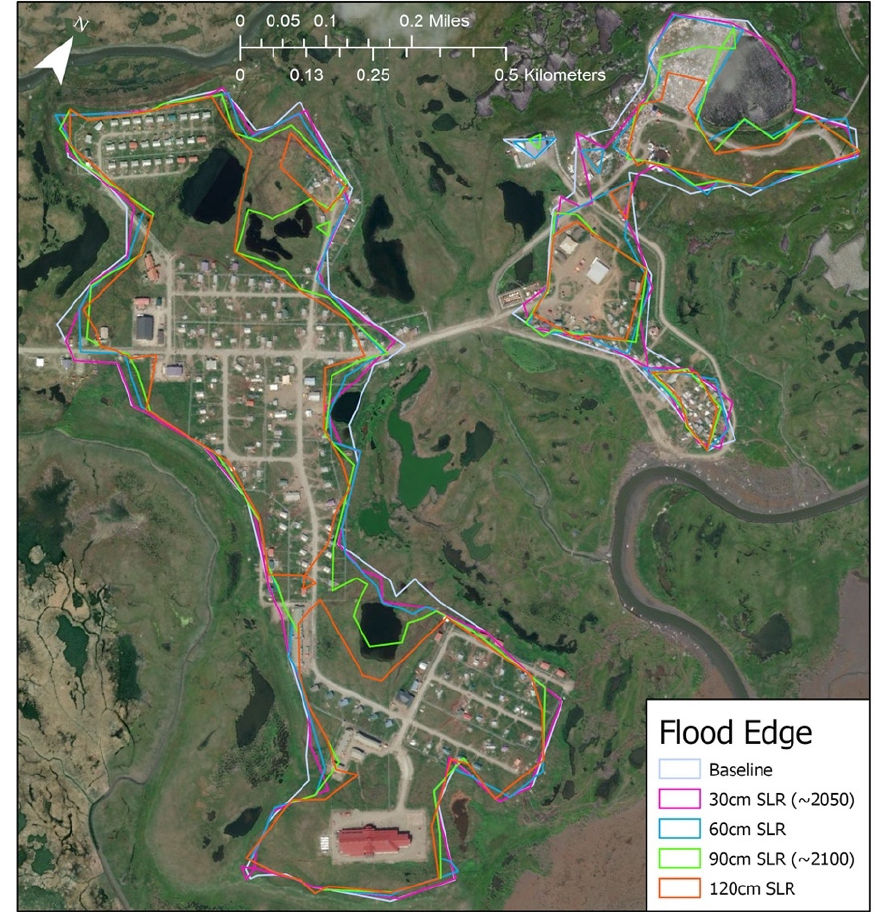
Figure 12. Flooding waterline in Hooper Bay.